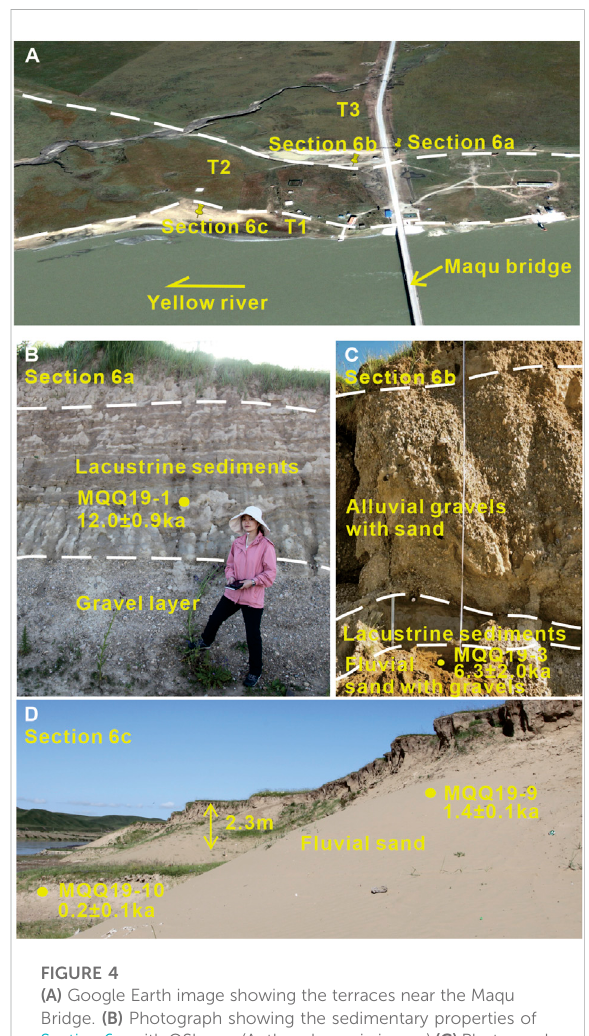
FIGURE 4 (A) Google Earth image showing the terraces near the Maqu Bridge. (B) Photograph showing the sedimentary properties of Section 6a, with OSL age. (Authorshown inimage) (C) Photograph showing the sedimentary properties of Section 6b, with OSL age. (D) Photograph showing the sedimentary properties of Section 6c, Q20 with OSL